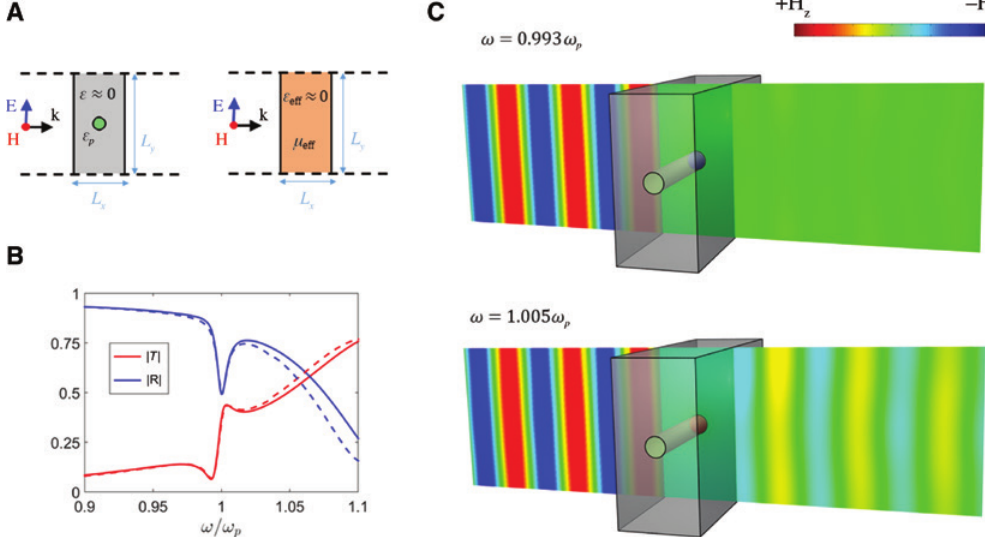
Figure 1: Transmission-reflection spectra of ENZ metasurfaces with photonic doping. (A) Sketch of the geometry: ENZ metasurface composed of rectangular unit cells of size L = 0.122 λ radius r and relative permittivity ε p p = 0.03 ω ω . (B) Transmission and reflection spectra. Comparison between the results obtained with a full-wave numerical simulation [44] c p of the ENZ metasurface (solid) and its homogeneous equivalent with effective permittivity ε (C) Snapshot of the magnetic field distribution (z-component) at the EMNZ ( ω = 1.005 ω